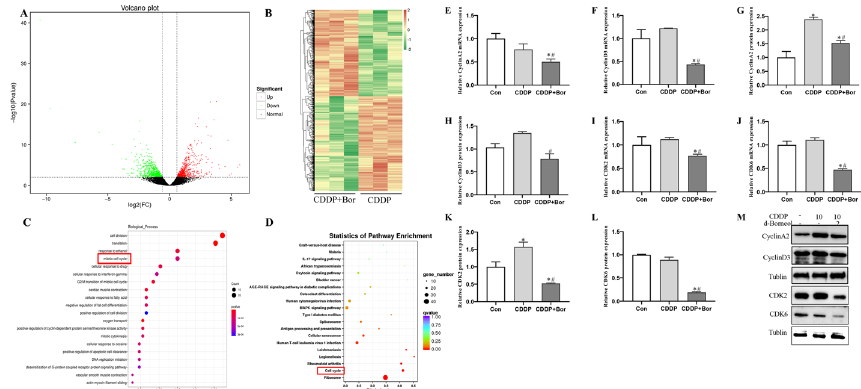
Fig. 4 RNA-seq revealed cotreatment with d-borneol and CDDP enriched in cell cycle. A Volcano plot displaying the dysregulated genes between CDDP Bor and CDDP groups; the red points represent + significantly upregulated genes, and the green points represent significantly downregulated genes in CDDP Bor; B heatmap showing differentially expressed genes in CDDP Bor treatment groups compared + + with CDDP groups; C GO enrichment analysis of biological processes of downregulated genes in CDDP Bor + treated group; D KEGG pathway enrichment analysis of downregulated differentially expressed genes in CDDP Bor group. Each group has three biological replicates; E – H , M mRNA expression level of cyclin A2 ( E ) + and cyclin D3 ( F ) and protein level of cyclin A2 ( G , M ) and cyclin D3 ( H , M ); I , J mRNA expression level of CDK2 ( I ) and CDK6 ( J ); K – M western blotting and quantification analysis of CDK2 and CDK6. All data are presented as mean SD ( n 3, * P < 0.05, compared with Con; # P < 0.05, compared with CDDP group) ± =